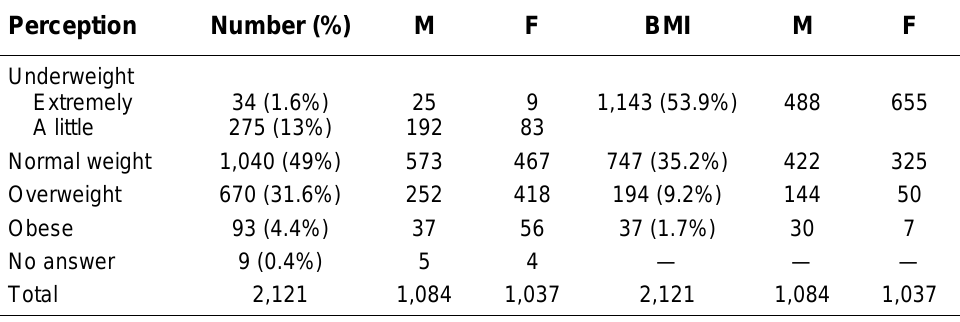
Perception of Own Body Self-Image in Relation with BMI, Adjusted for Age and